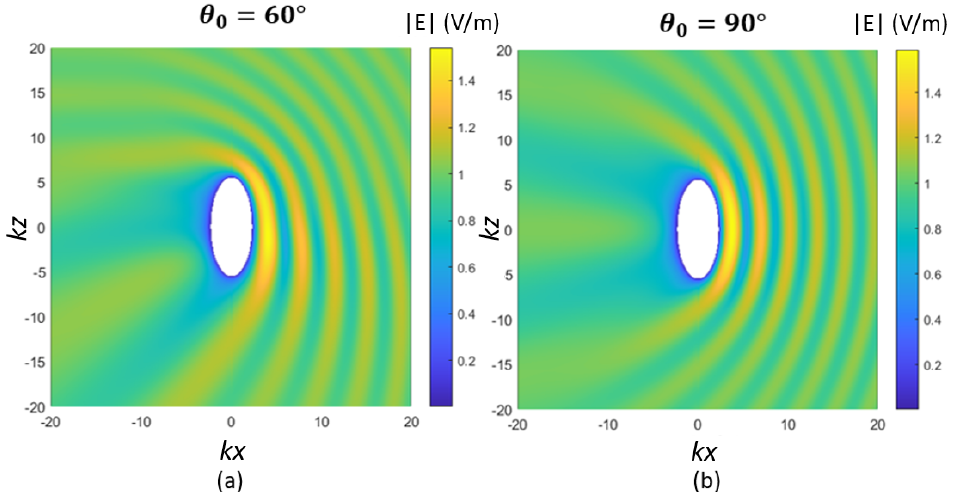
Figure 4. Magnitude of the E-field across the plane xz for the same geometrical parameters of Figure 2 but for different incident angles of the plane wave: ( a ) θ 0 = 60 ◦ , ( b ) θ 0 = 90 ◦